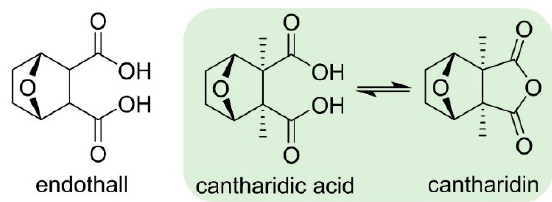
Figure 7. Structure of endothall, cantharidin and its dicarboxylic acid analog.